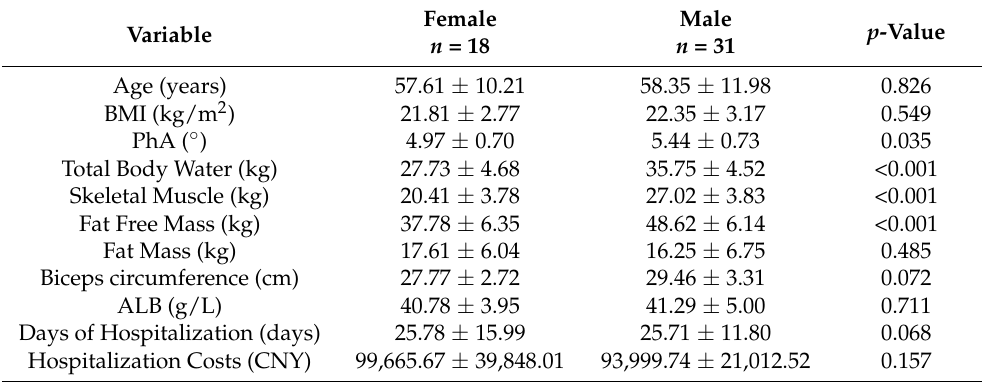
Table 1. Patient characteristics at baseline.